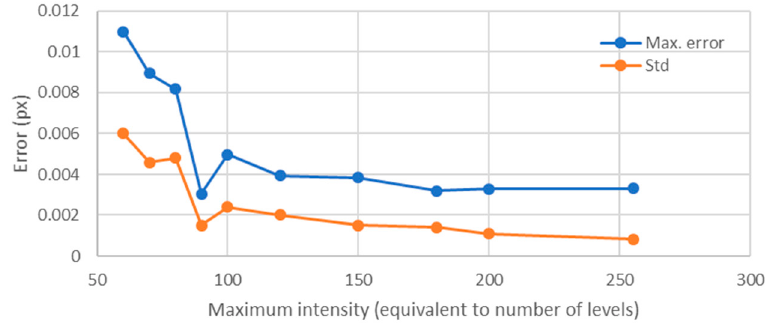
Figure 17. Influence of illumination for a point radius of 25 px and an area ratio of 12.42.